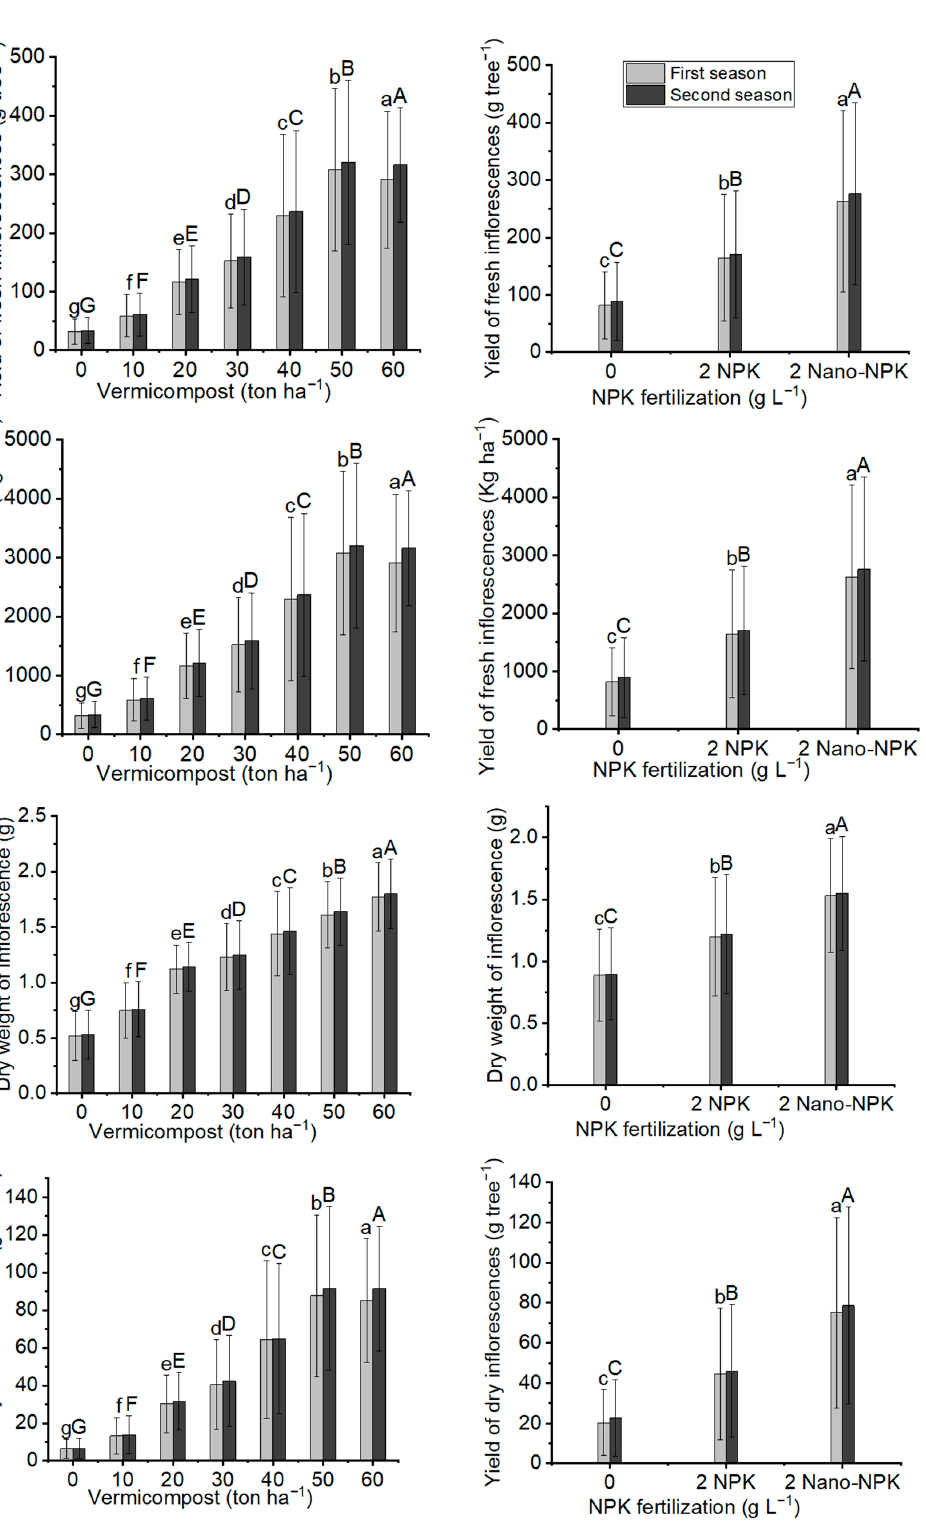
Figure 4. In both seasons of the study, the mean values of yield of fresh inflorescences (g tree − 1 ), yield of fresh inflorescences (kg ha − 1 ), and dry weight of inflorescence (g), and yield of dry inflorescences (g tree − 1 ) of Moringa oleifera trees as influenced by vermicompost and NPK fertilization are provided below. The data are presented as a mean with standard error ( n = 3). Bars with identical lowercase letters are not significant at the 0.05 level of